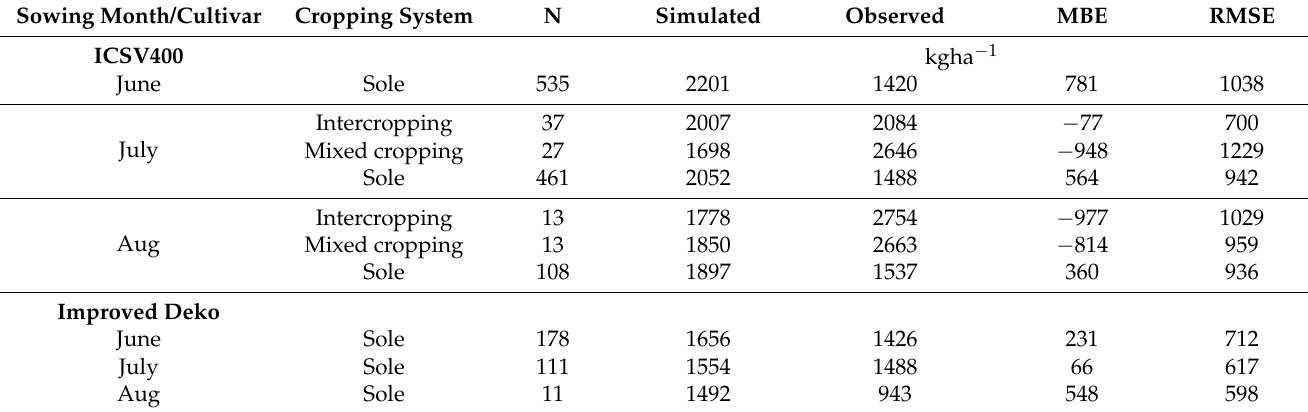
Figure 1. ( a ) Observed vs. simulated grain yield using experiment conducted in 2016–2018 growing seasons for cultivar ranges from early to late maturing. ICSV-400 (MBE = 103 kgha − 1 ; RMSE = 617 kgha − 1 , RMSE n = 28.7%); Improved Deko (MBE = 114 kgha − 1 , RMSE = 370 kgha − 1 , RMSE n = 18.7%); Samsorg-44 (MBE = 279 kgha − 1 ; RMSE = 377 kgha − 1 , RMSE n = 17.2%); CSR01 (MBE = − 48 kgha − 1 , RMSE = 301 kgha − 1 , RMSE n = 13.8%); SK5912 (MBE = 234 kgha − 1; RMSE = 254 kgha − 1 , RMSE n = 9.2%). ( b ) Observed vs. simulated total biomass using experiment conducted in 2016–2018 growing seasons for cultivar ranges from early to late maturing. ICSV-400 (MBE = 28 kgha − 1 , RMSE = 1249 kgha − 1 , RMSE n = 19.5%); Improved Deko (MBE = 2344 kgha − 1 , RMSE = 2621 kgha − 1 , RMSE n = 36.8%); Samsorg-44 (MBE = − 1100 kgha − 1 ; RMSE = 1432 kgha − 1 , RMSE n = 12.5%); CSR01 (MBE = − 976 kgha − 1 , RMSE = 1687 kgha − 1 , RMSEn = 16.5%); SK5912 (MBE = − 429 kgha − 1 ; RMSE = 868 kgha − 1 , RMSE n = 6.9%). Table 6. Statistical indices for model validation of contrasted sorghum cultivars across planting date and cropping system from on-farm production technology between 2013 and